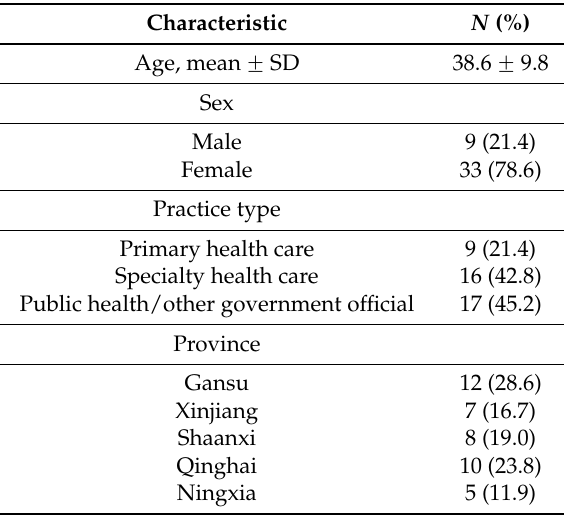
Table 3. Description of respondents and their practices.